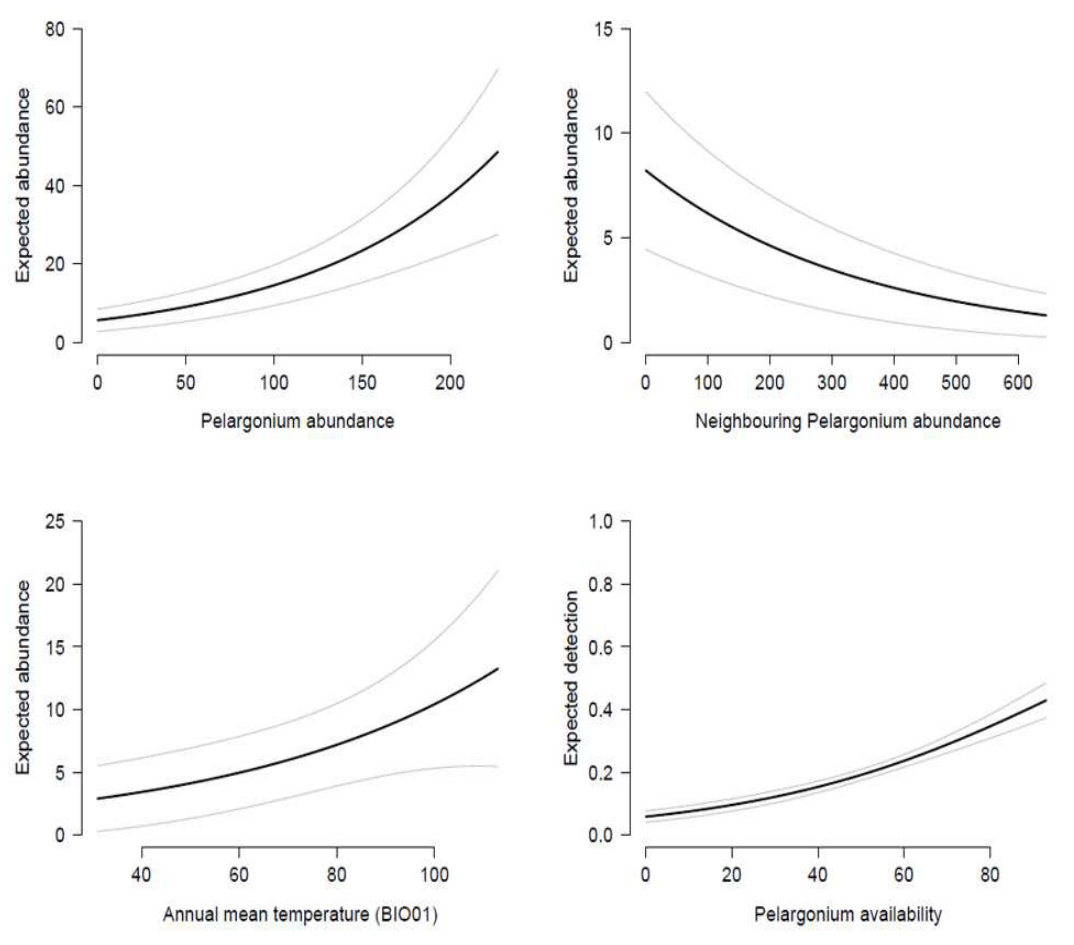
Figure 3. Single covariate responses in relation to the expected abundance and detection predicted by the best N-mixture model. Grey lines indicate 1-SE bounds. Table 2. Model selection of N-mixture models for Cacyreus marshalli egg abundance. Annual